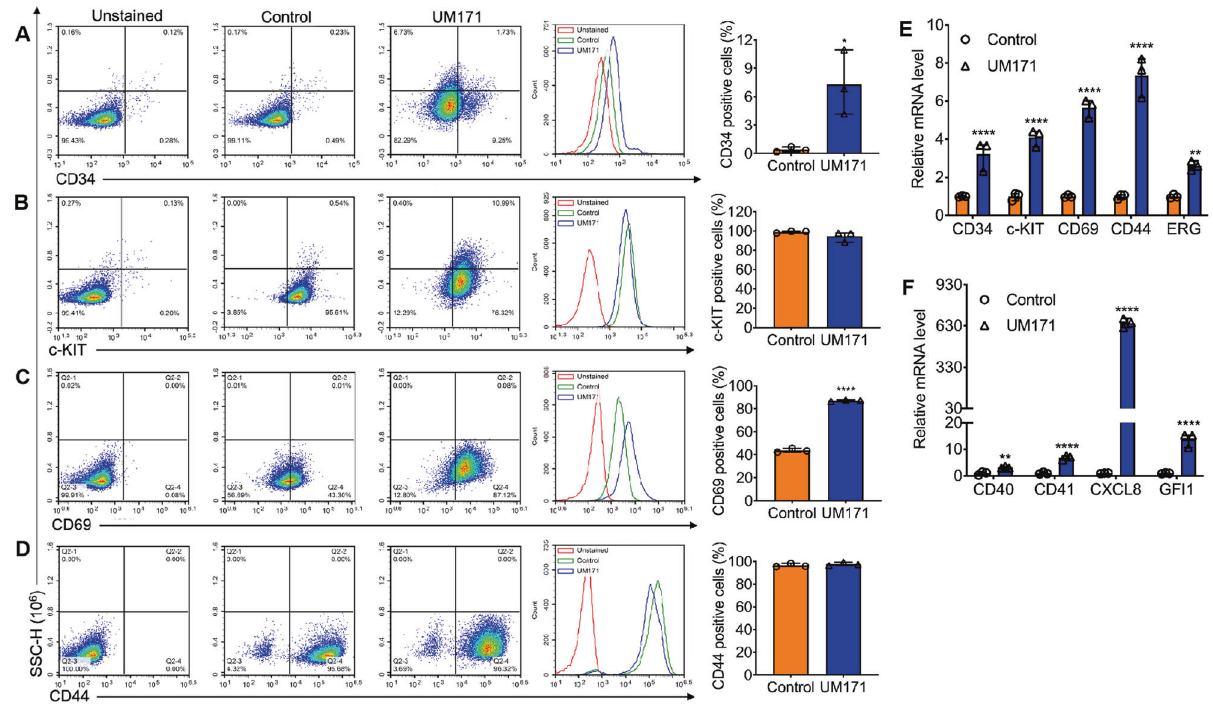
Fig. 2 Induction of stem cell markers by UM171 in HEL cells. A – D The Bi-potential Megakaryocytic Erythroid Progenitor (MEP) derived HEL cell line was treated with UM171 (6 μ M), DMSO for 24 hours and subjected to fl ow cytometry analysis for the stem cell markers CD34 ( A ), c-KIT (B), CD69 ( C ) and CD44 ( D ). E , F Q-RT-PCR analysis of HEL cell treated with UM171 (3 μ M) and DMSO for expression of the stem cell markers CD34, c-KIT, CD69, CD44, ERG ( E ) and CD40, CD41, CXCL8 and GFI1 ( F